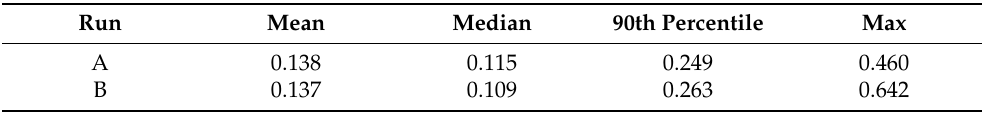
Table 2. Variation in Vive measurement in mm for a stationary target. Each run was conducted with a different tracker position and